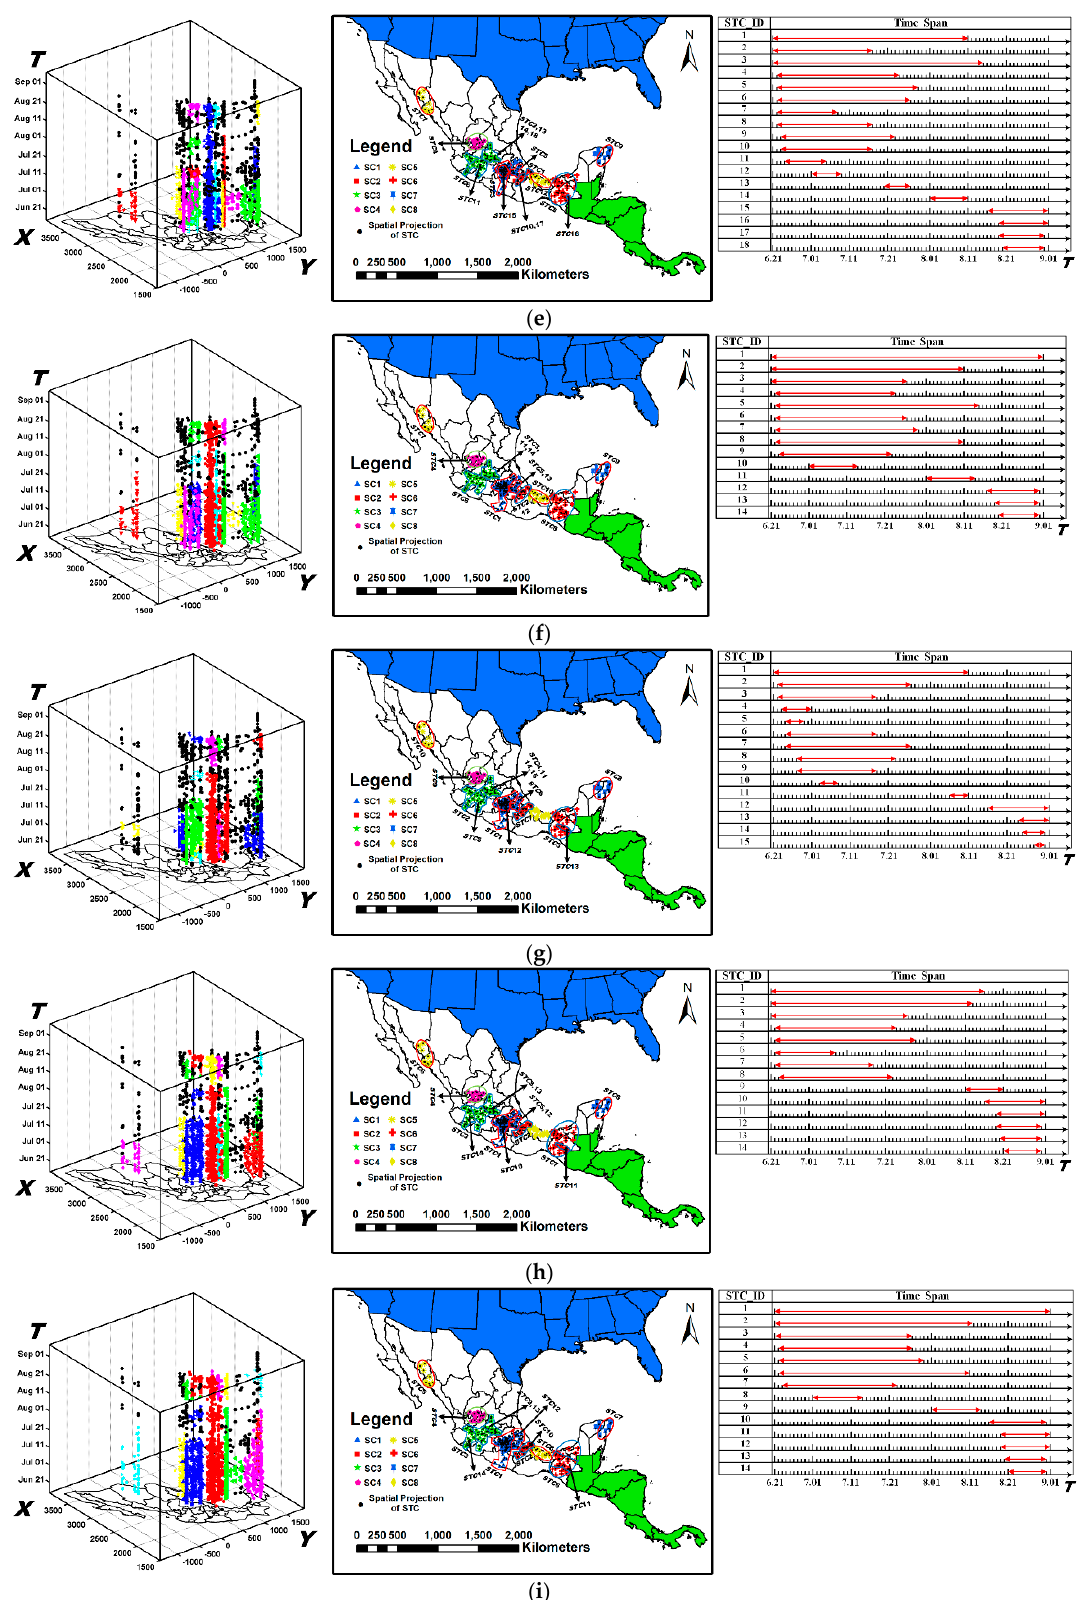
Figure 14. The spatio-temporal clusters in STTE that form the spatial clusters in STE and their spatial locations and time periods. ( a ) δ = 1, ε = 1; ( b ) δ = 1, ε = 2; ( c ) δ = 1, ε = 3; ( d ) δ = 2, ε = 1; ( e ) δ = 2, ε = 2; ( f ) δ = 2, ε = 3; ( g ) δ = 3, ε = 1; ( h ) δ = 3, ε = 2; ( i ) δ = 3, ε = 3.